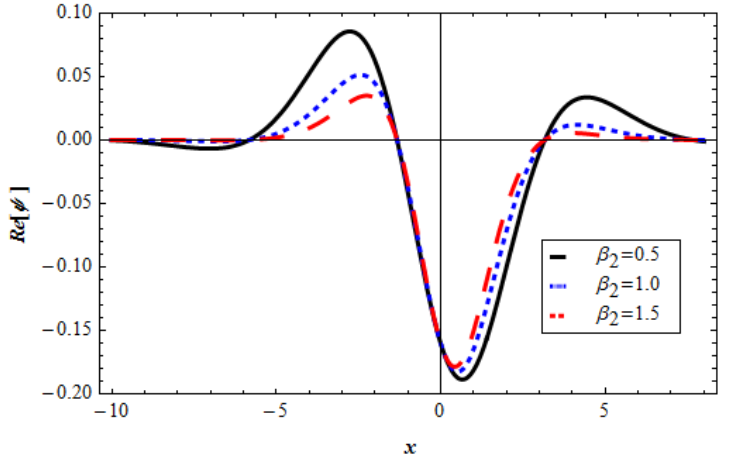
Figure 12. Change of solution (20) with z , t , β 2 for c = 0.5, v = 0.7, β 1 = 0.1, β 3 = 0, β 4 = 0.